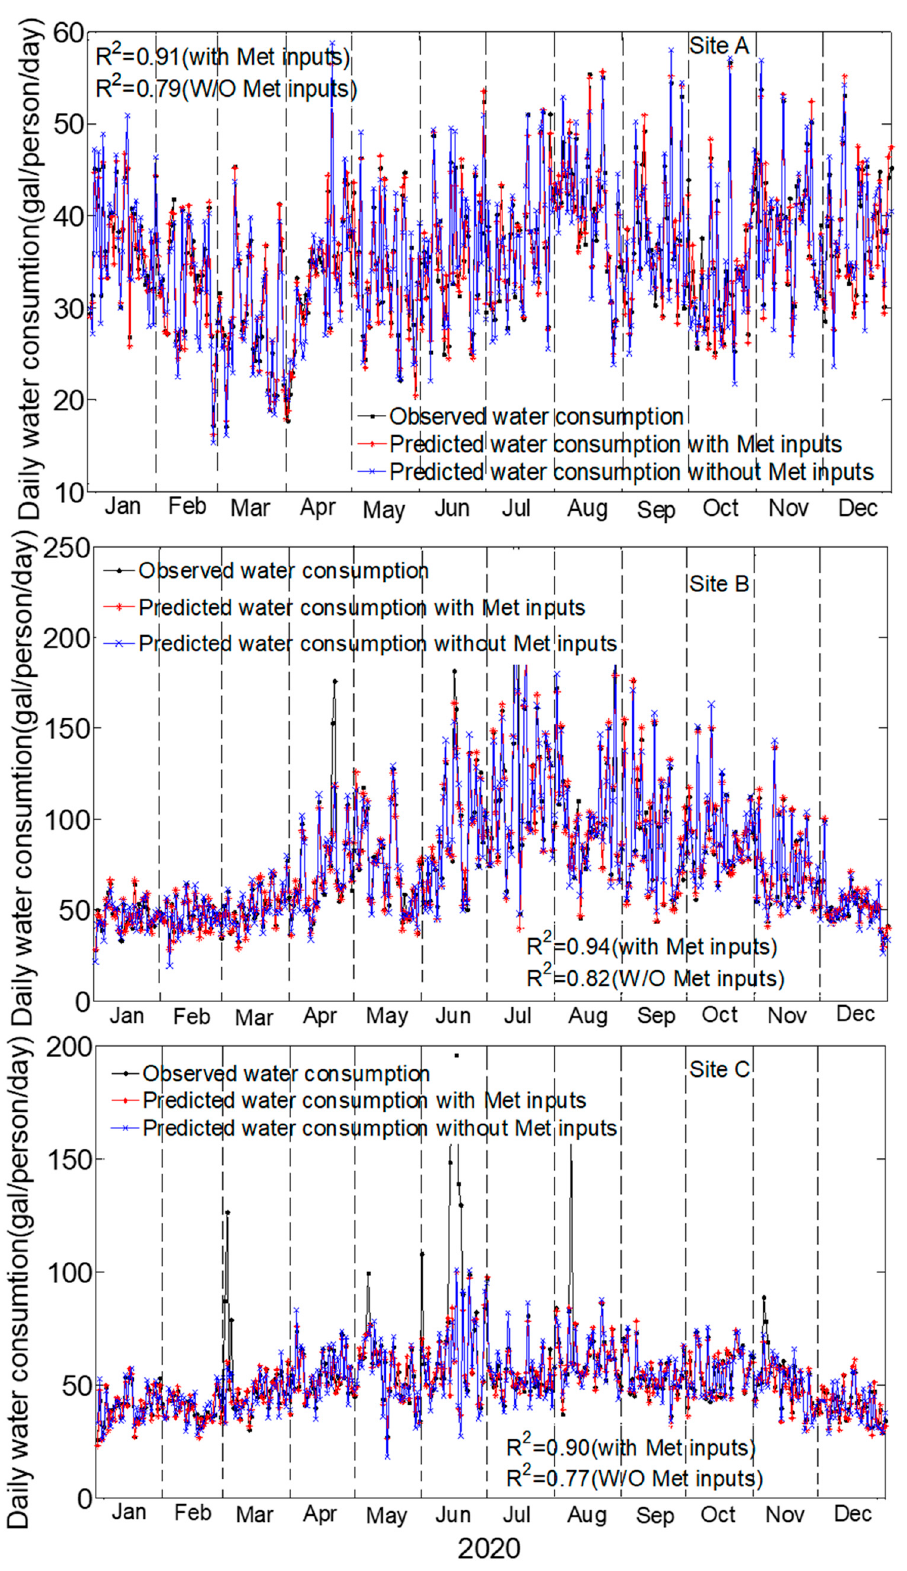
Figure 8. Illustration of validation of daily water use (gal/person/day) ARMA models with (red) and without (blue) meteorological (“Met”) for the three study sites. Note: training data for sites { A – C } were for the periods October 2015–June 2019 and October 2015–December 2019, respectively (Figure 6).